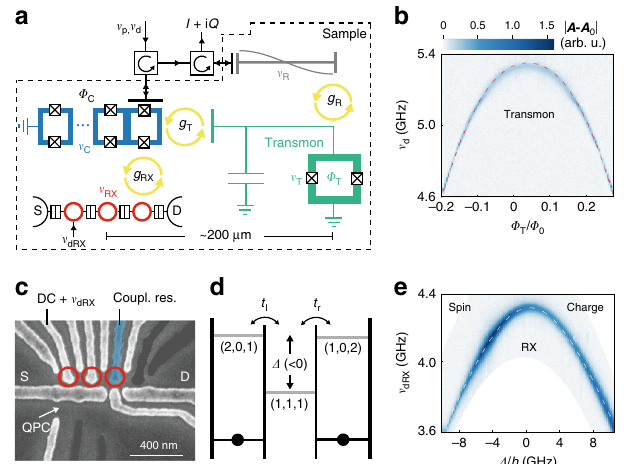
(probe) and ν (drive) are routed with p d is measured. The sample (dashed line) contains four quantum systems with transition p , blue), an RX qubit ( ν , red), a transmon ( ν , green) and a read-out C RX T can be applied to one of the dots. Crossed squares denote the Josephson junctions of dRX and Φ denote coupling resonator and C T = Φ ν and Φ as obtained from the system Hamiltonian. c Scanning 0 . The dashed line indicates d T T and t and the electrochemical potentials, l r , N , N ) with N electrons in the left, N electrons in the middle and N electrons in the right quantum l m r l m r ’ ν ¼ 4 : 84 GHz as a function of Δ and ν . The p C dRX